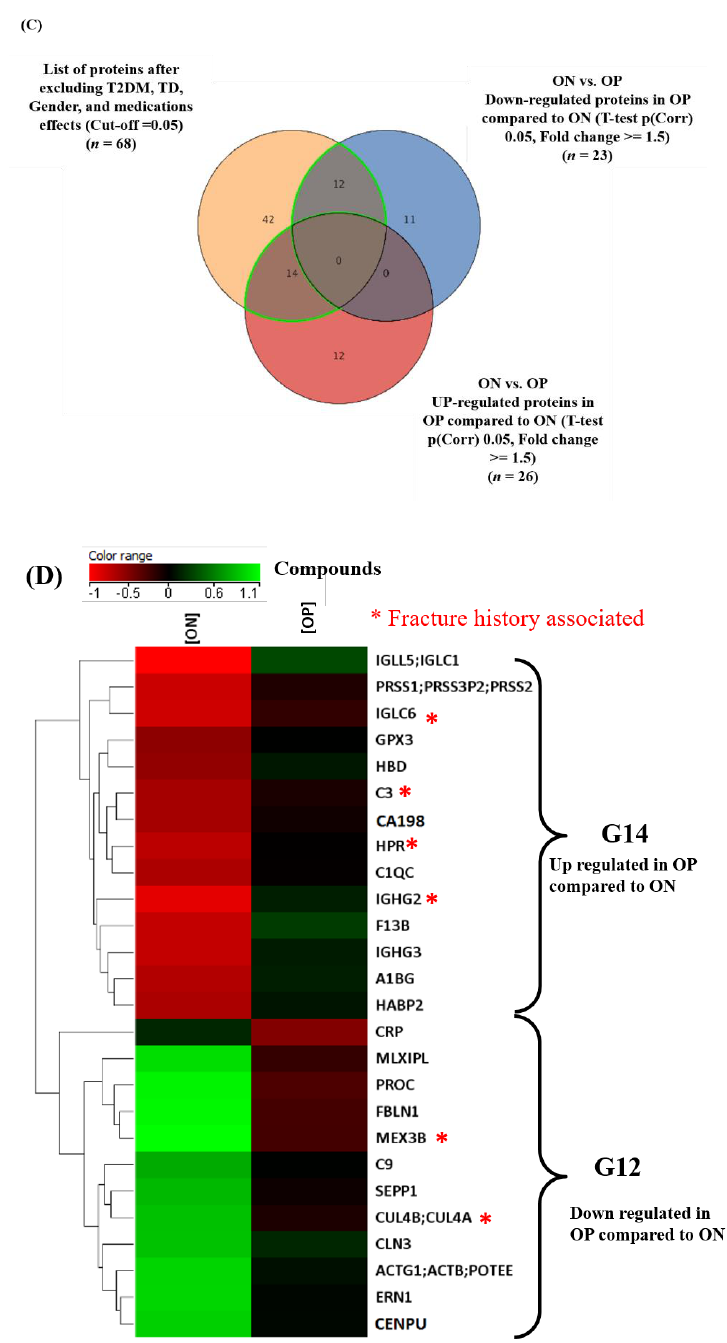
Figure 3. Proteomics profiling between ON and OP patients. ( A ) Orthogonal partial least squares-discriminant analysis (OPLS DA) score plot showing the relative separation between ON and OP groups (Q 2 = 0.876, and R 2 = 0.991) after excluding three outlier values detected using the random forest algorithm. ( B ) Volcano plot analysis of ON versus OP showing significantly dysregulated proteins (false discovery rate (FDR)-corrected p value < 0.05, and fold change (FC) > 1.5 or < 0.67). A total of (G49) proteins were found to be dysregulated (26 up-regulated and 23 down-regulated) in OP patients, compared to those in ON patients. ( C ) Venn diagram illustrating an overlap between the confounder’s independent proteins ( n = 68) and the dysregulated proteins between the ON and OP groups (G49). A total of 26 proteins were significantly dysregulated (14 up-regulated